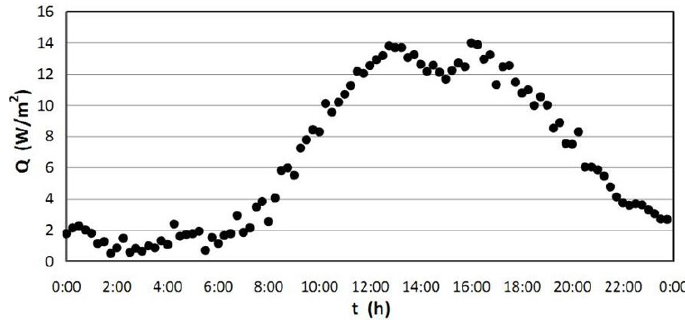
Figure 10. Measured heat flow through the triple glazing. Scenario 1